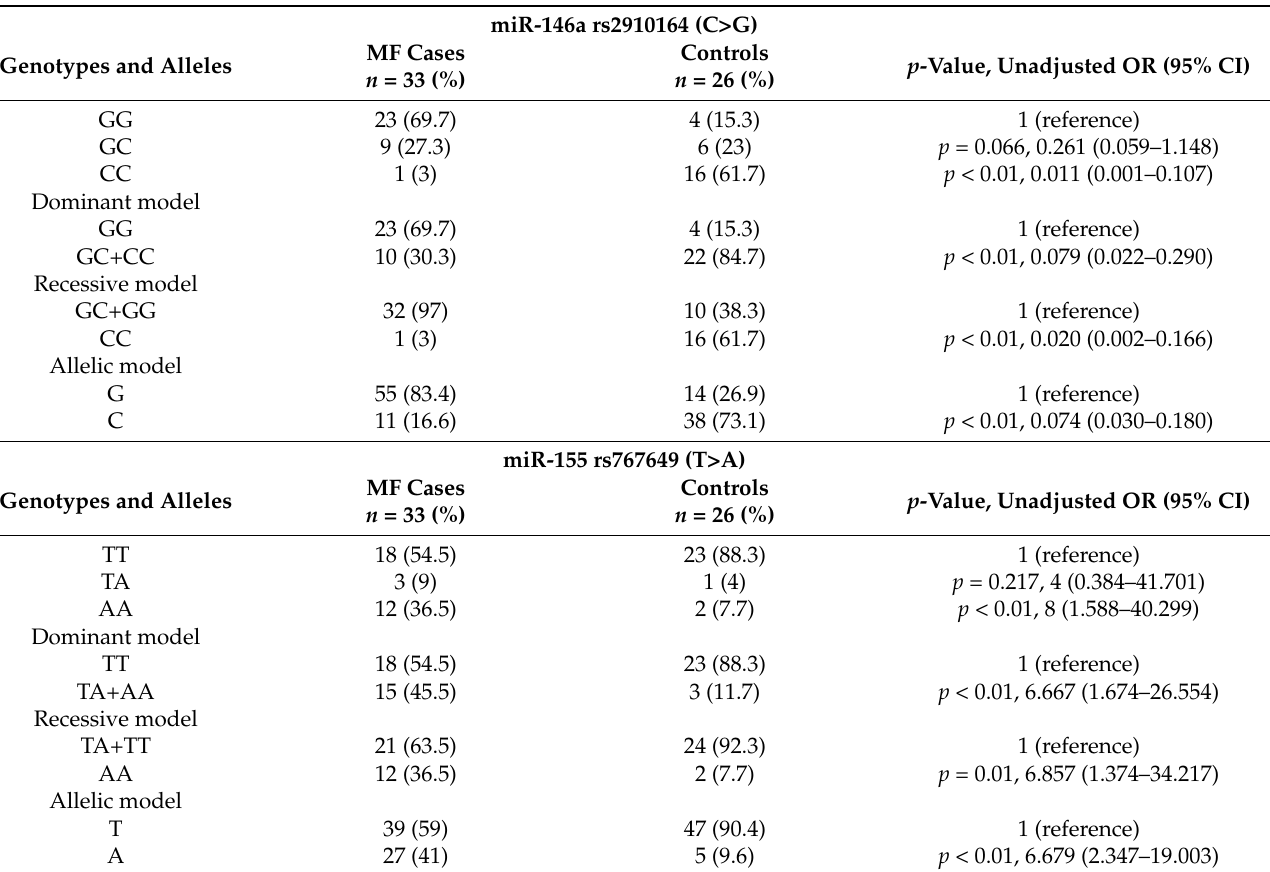
Table 2. Allelic and genotypic distribution of miR-146a rs2910164 (C>G) and miR-155 rs767649 (T>A) between MF patients and